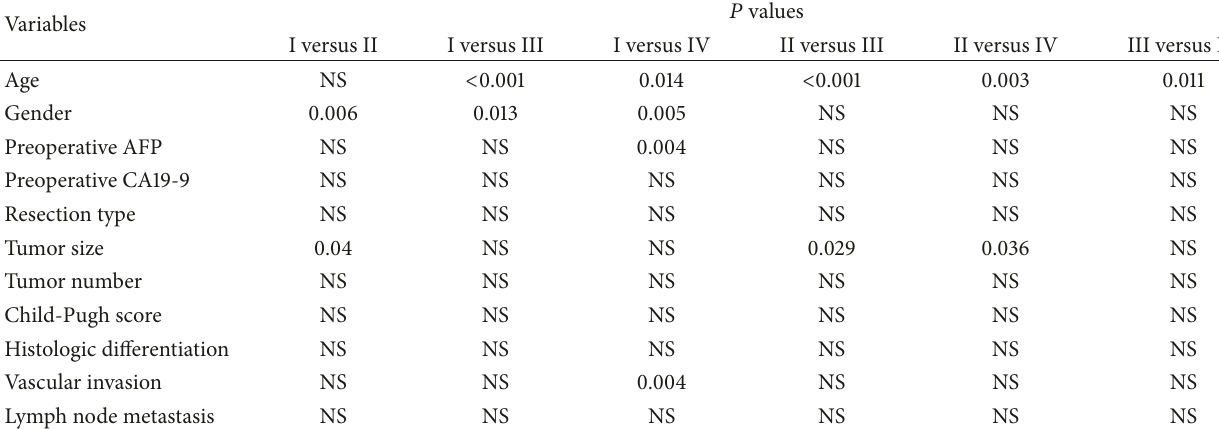
Table 2: Between-group comparison of the clinicopathological characteristics.